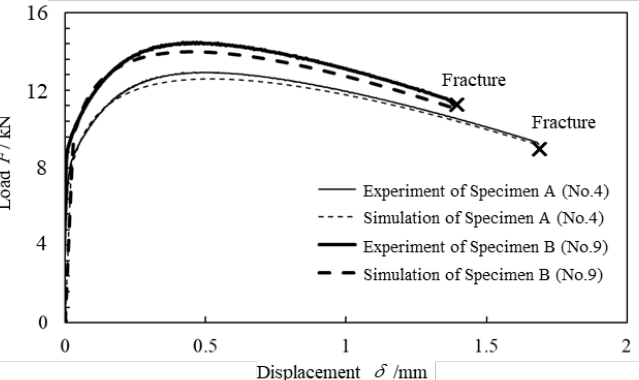
Figure 8. Load – displacement relationship in the uniaxial tensile test of notched round bar specimen without prior compression.